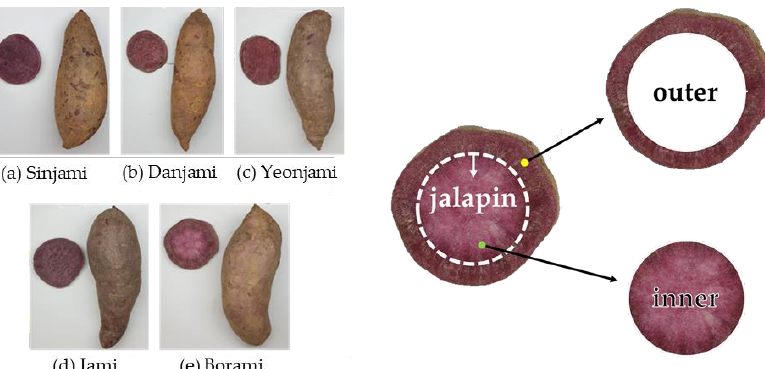
Figure 1. Images of the five purple sweet potato cultivars harvested in Korea and a diagram indicating the jalapin, outer, and inner layers of Borami, defined in this study.